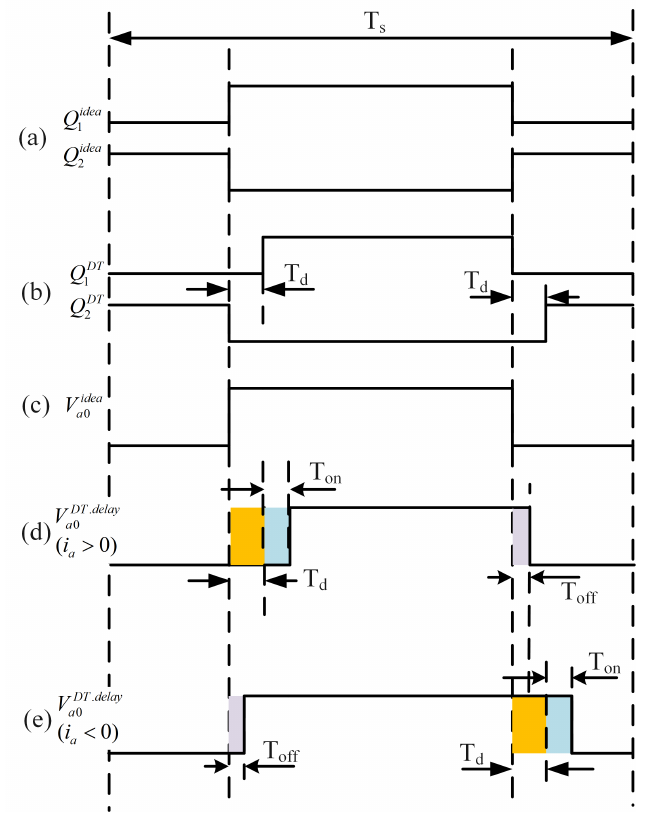
Figure 2. Switching pattern and terminal voltages: ( a ) Ideal gate signals. ( b ) Real gate signals with dead-time; ( c ) Ideal terminal voltage; ( d ) terminal voltage with dead-time and time delay when i a > 0; ( e ) Actual terminal voltage with dead-time and time delay when i a <